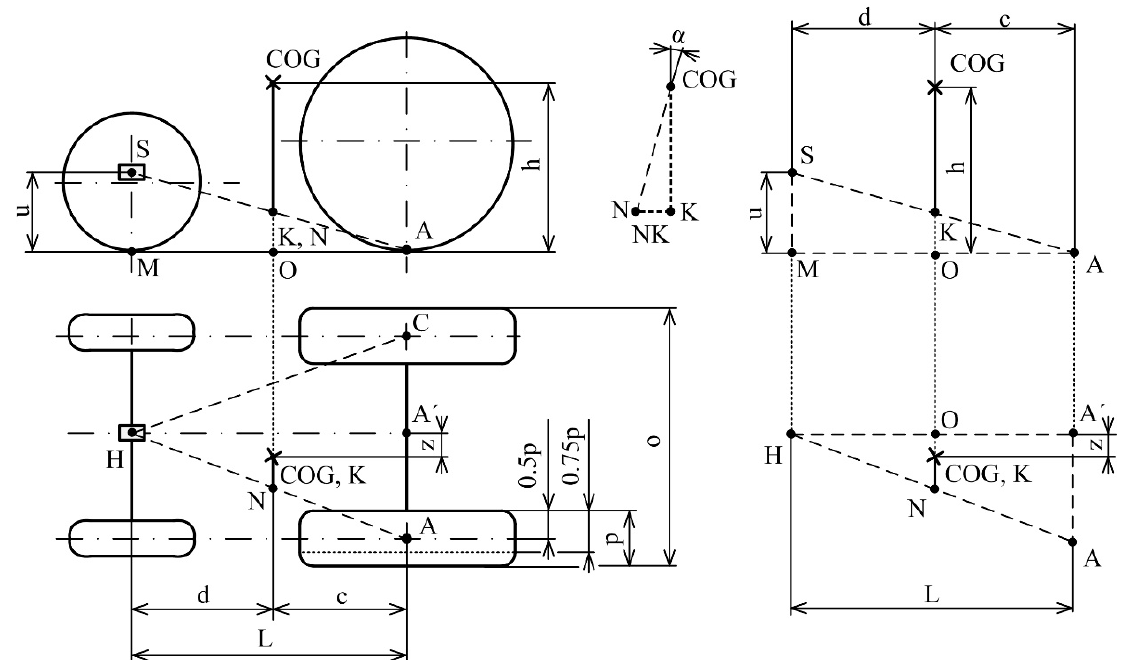
Figure 7. Calculation of static overturning angle according to [25] : o— overall tire width of the fixed axle; p— tire width on the fixed axle; u— the height of the swelling axle pivot point; L— wheelbase; c, d— longitudinal coordinates of COG; h— vertical coordinate of COG; z— lateral position of COG; α — static overturning angle; AA´— base line of the stability triangle; NK— lateral distance between the vertical projection of COG and line AH; A, A’, B, C, D, F, H, M, S — specific points needed for determination of abscissae.